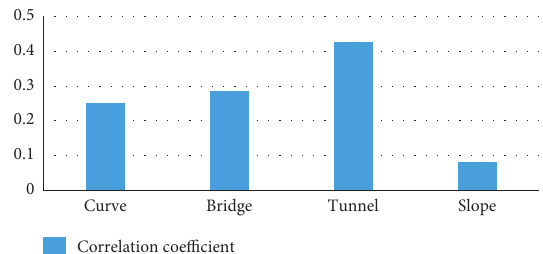
Figure 2: Correlation coefficient between gearbox temperature and line